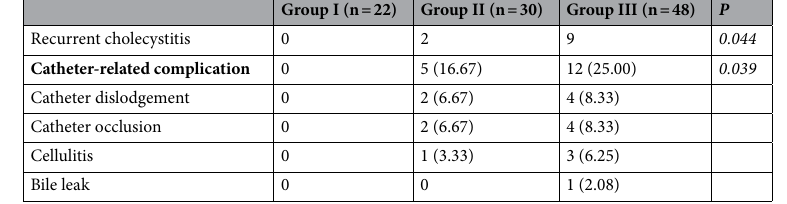
Table 2. The outcomes in waiting time. Values were presented n